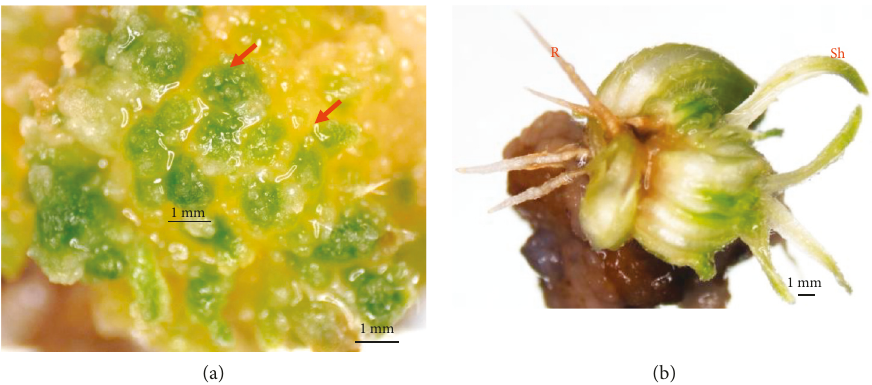
Figure 3: Callus characteristics after culture on MS medium containing 4 mg/l BA with 0.5 mg/l NAA for four weeks. Green spot (arrows) formation on callus (a) and adventitious shoot (Sh) and root (R) derived from callus